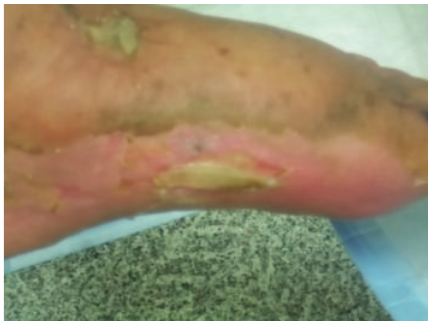
Figure 7: Two months postradiation: marked diminishment of cutaneousulcerationwithdeclineindischargeanddryingofsatellite